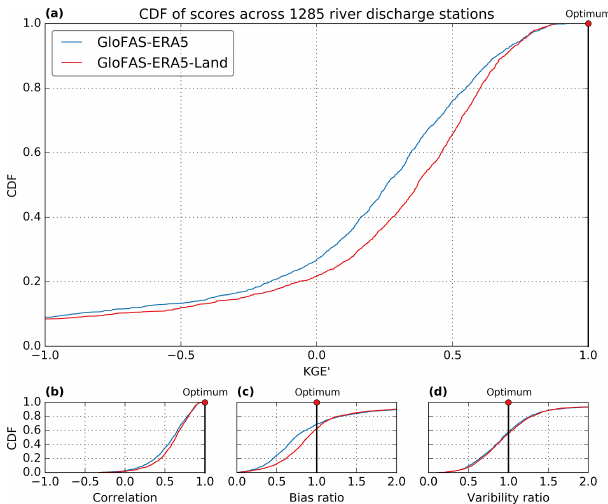
Figure 13. Cumulative distribution functions (CDFs) of hydrologi- cal performance metrics across 1285 observation stations. Modified Kling–Gupta efficiency (KGE (cid:48) ) (a) with decomposition of KGE (cid:48) into Pearson correlation (b) , bias ratio (c) , and variability ratio (d) for GloFAS-ERA5-Land (red line) and GloFAS-ERA5 (blue line). The red dot marks the optimum value for each